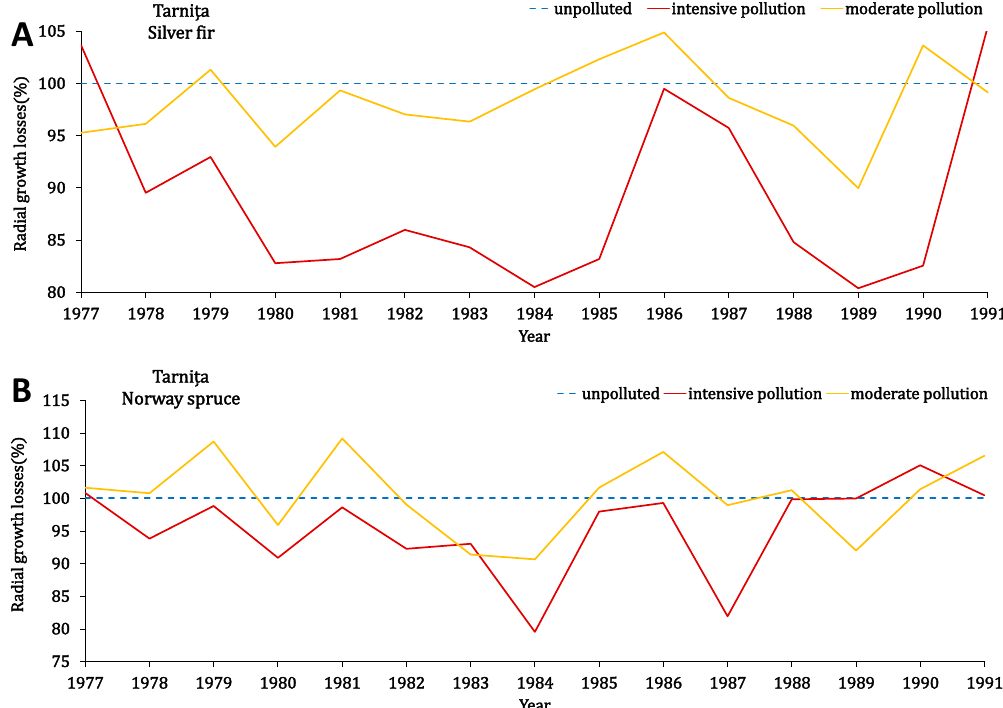
Figure 5. Radial growth losses recorded by the trees (( A ) silver fir; ( B ) Norway spruce) in the Tarni ț a area affected by moderate and intensive air pollution. At the stand level, the most affected trees by the local industrial pollution were the silver fir trees, while Norway spruce trees were less affected.